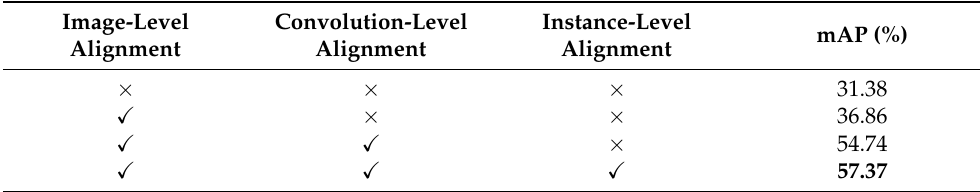
Table 2. The impact of different level alignments on detection performance. The best result is indicated by bold.